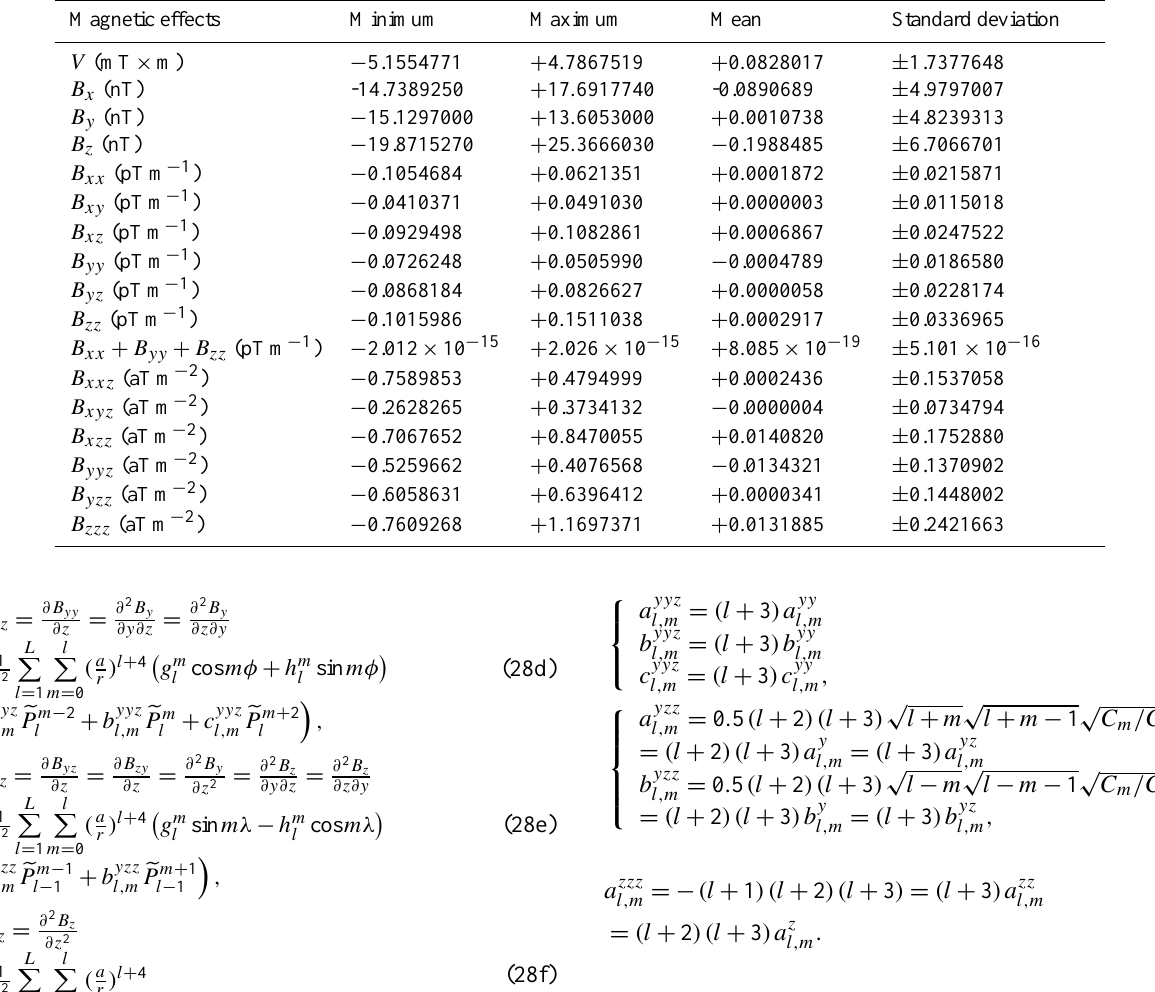
Table 1. Statistics of the magnetic potential, MV, MGT and third-order partial derivatives of the magnetic potential field around the North Pole (0 ◦ ≤ θ ≤ 30 ◦ ) at the altitude of 300km using the lithospheric magnetic field model GRIMM_L120 (version 0.0) (Lesur et al., 2013) for spherical harmonic degrees